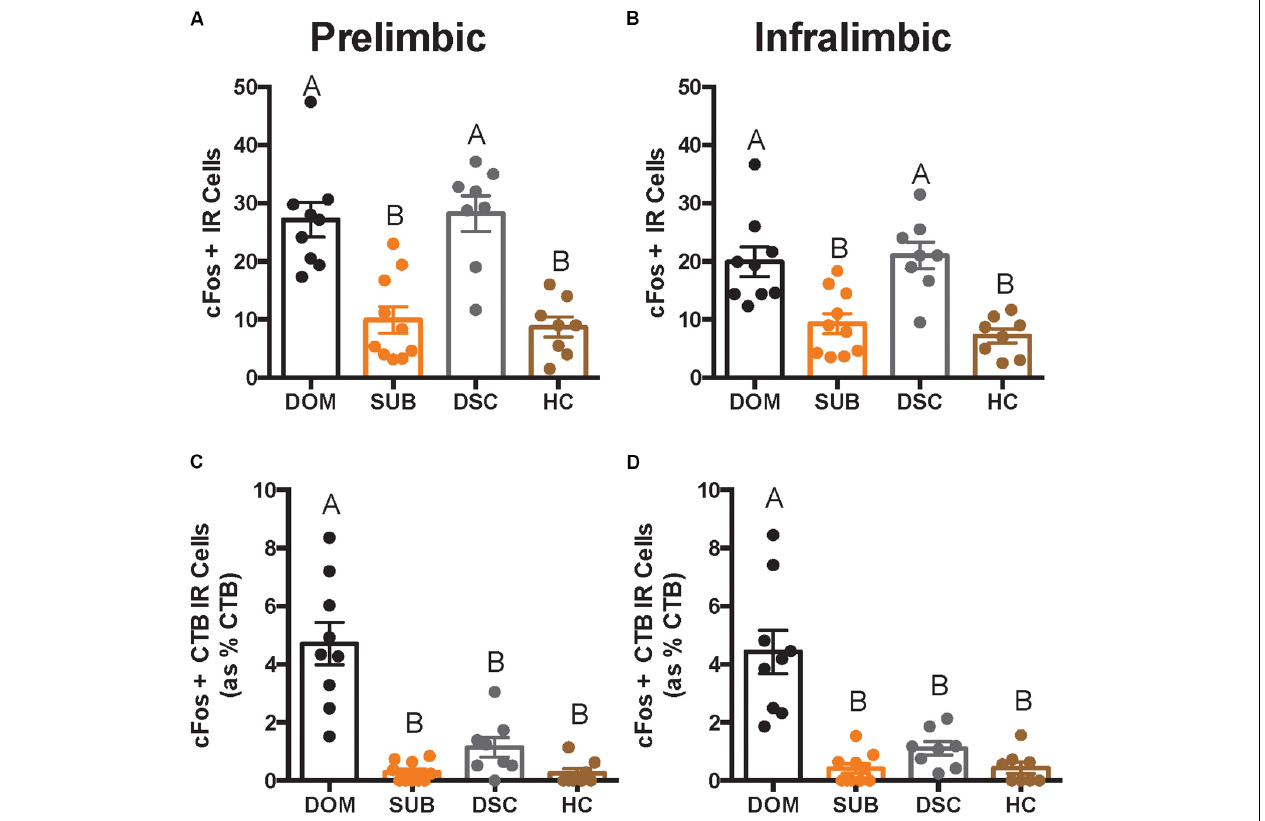
FIGURE 4 | Total number of cFos IR cells and cFos+ CTB IR cells in deep cortical layers is shown as quantified across an average of 12 replicates within a volume of 439 µ m × 660 µ m × 40 µ m (width × height × thickness) in a per subregion , per hemisphere , per slice manner. In both prelimbic (A) and infralimbic (B) subregions, dominant hamsters (DOM) differed significantly in total cFos IR when compared with subordinate (SUB) and handled controls (HC), but not dominance status controls (DSC). On the other hand, DOM differed from all other groups in dual-labeled cells (shown as a percentage of total CTB+ cells) in both prelimbic (C) and infralimbic (D) cortices. Letters above each bar indicate statistical significance only where different (i.e., “A” differs from